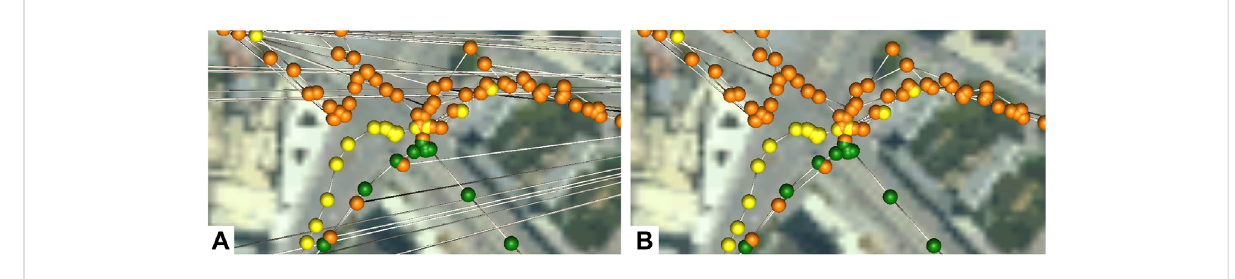
FIGURE 1 GPS points measured with mobile sensors connected according to the driven/walked route (direction from white to black) with GPS outlier (A) and after removing GPS outlier (B) .